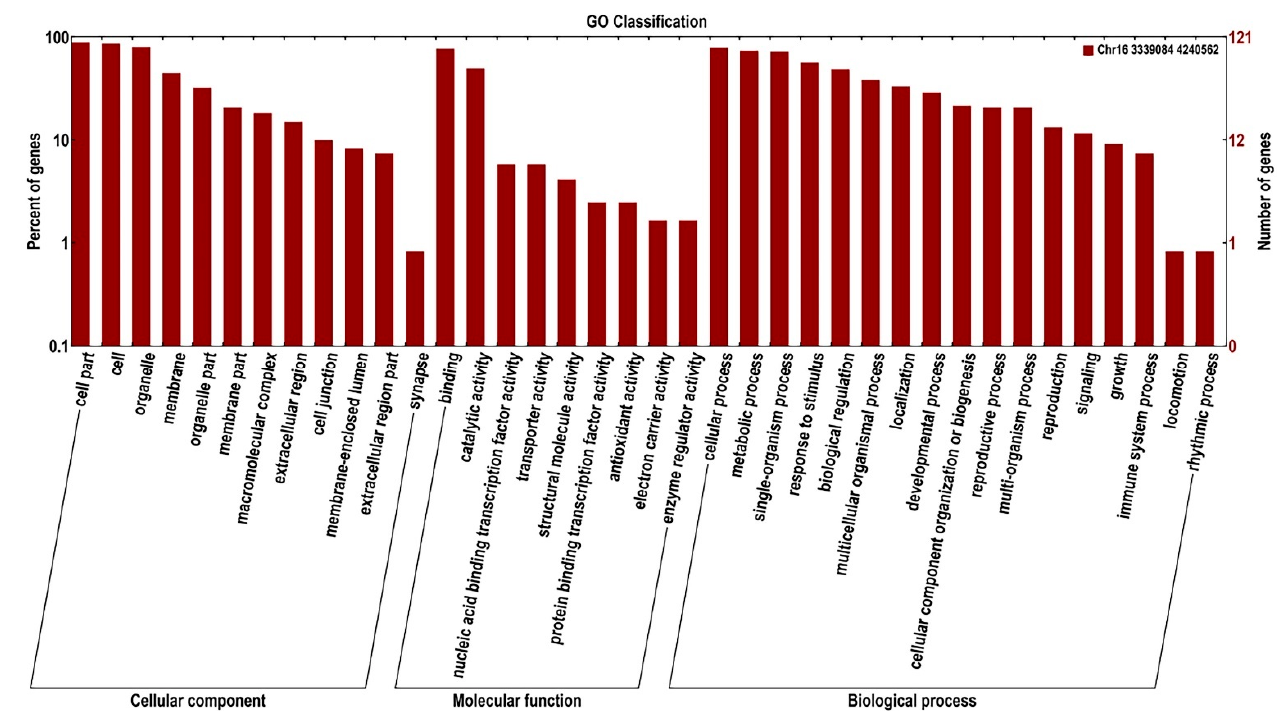
Figure 6. GO enrichment and classification of the candidate genes for NNMS under well-watered and drought conditions.